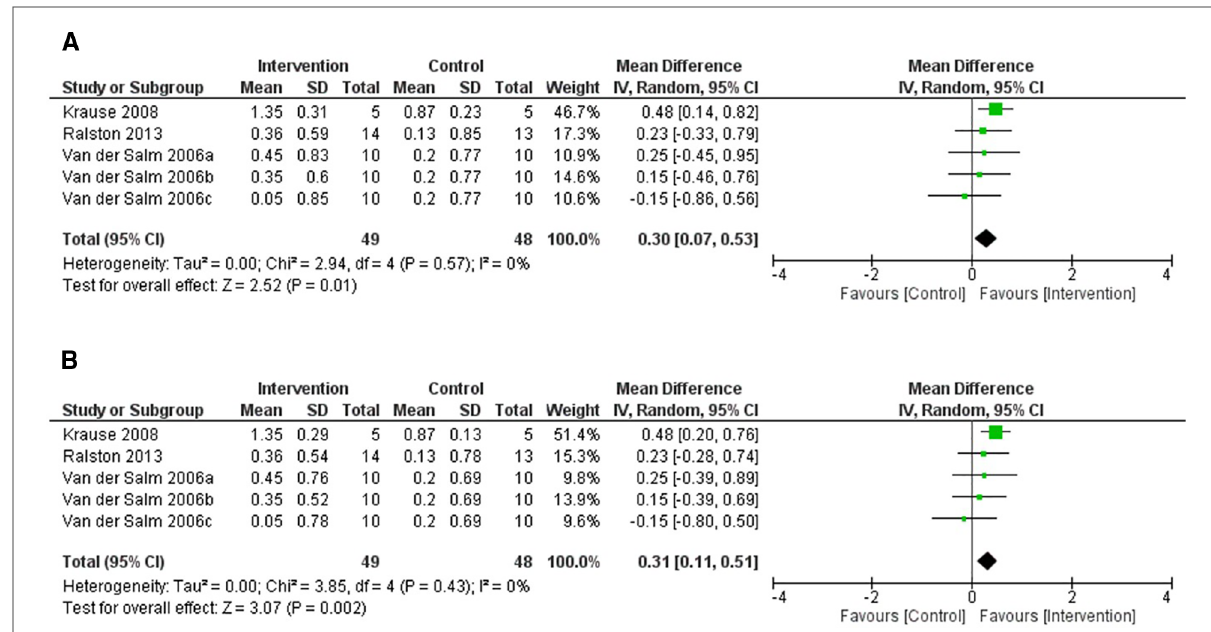
FIGURE 3 Forest plot using a random effects model of RCT studies using the MAS to test for the acute effects of non-invasive electrical stimulation. 2006a-c represent the 3 interventions that were tested in the single study performed by Van der Salm et al. (2006): TENS delivered to the agonist, antagonist and the S1 dermatome respectively. The black diamond represents the average effect of non-invasive electrical stimulation. ( A ) shows results for Corr= 0.1 and ( B ) for Corr=0.2. CI=con fi dence interval, MAS=modi fi ed Ashworth scale, RCT=randomised-control trial, TENS=transcutaneous electrical nerve